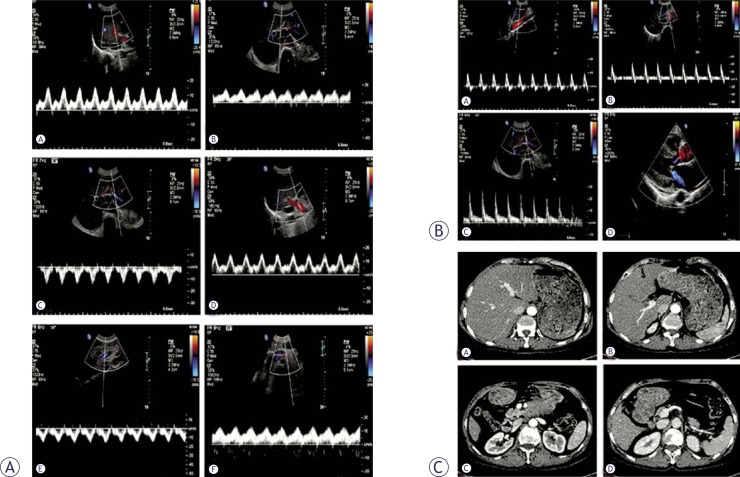
Diffuse extrahepatic APFs with indiscoverable focal lesions, confirmed by multimode imaging findings. (A) Color duplex US images of the portal system with normal internal diameter demonstrate typical arterial-like results with a continuous hepatopetal flow (a: right branch, b: left branch, c: sup. segmental brr., d: main trunk, e: superior mesenteric vein, f: splenic vein). (B) High-resistivity of multiple organs (a: triphase velocity tracing of abdominal aorta, b: triphase velocity tracing of hepatic artery, c: velocity tracing of intrahepatic artery with a high RI, d: hypertrophic left ventricular wall with aortic and mitral regurgitation). (C) Stronger enhancement of the affected superior mesenteric and splenic vein than that of the portal vein. (a: left branch, b: right posterior branch c: equal enhancement of superior mesenteric vein and its parallel running artery, d: stronger enhancement of the affected splenic vein than that of portal vein).